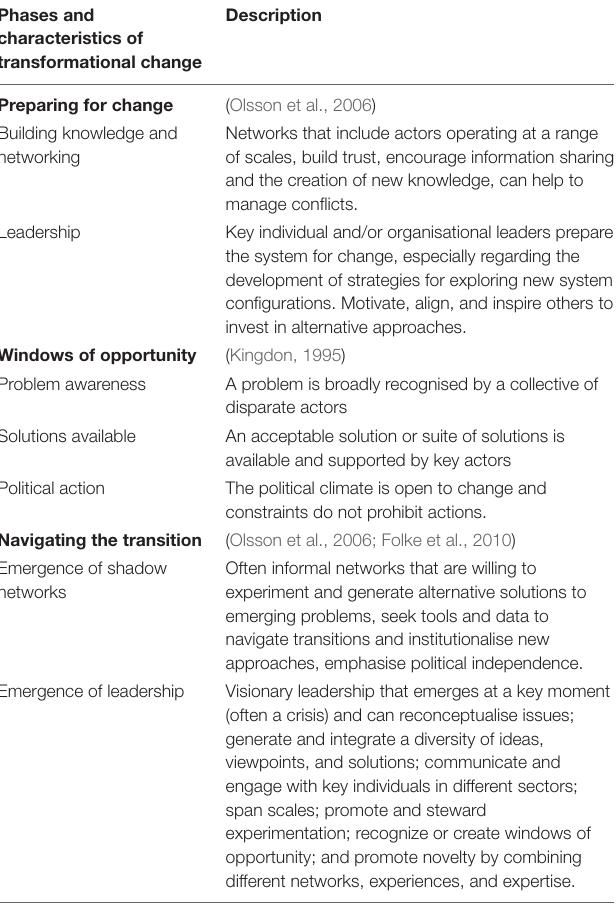
TABLE 5 | Evaluation criteria associated with transformational change in CE management and governance